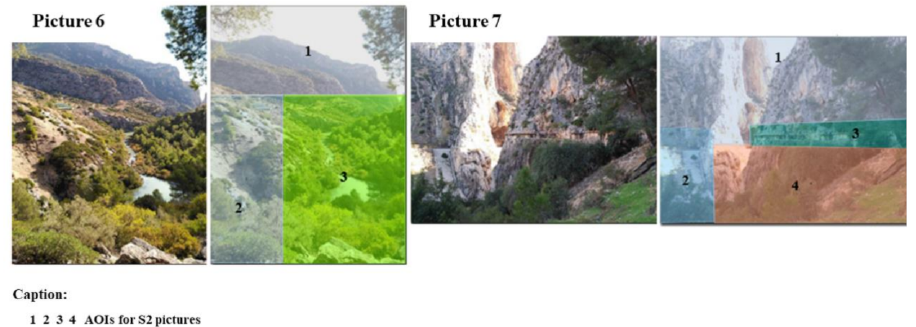
Figure 5. AI images for zone